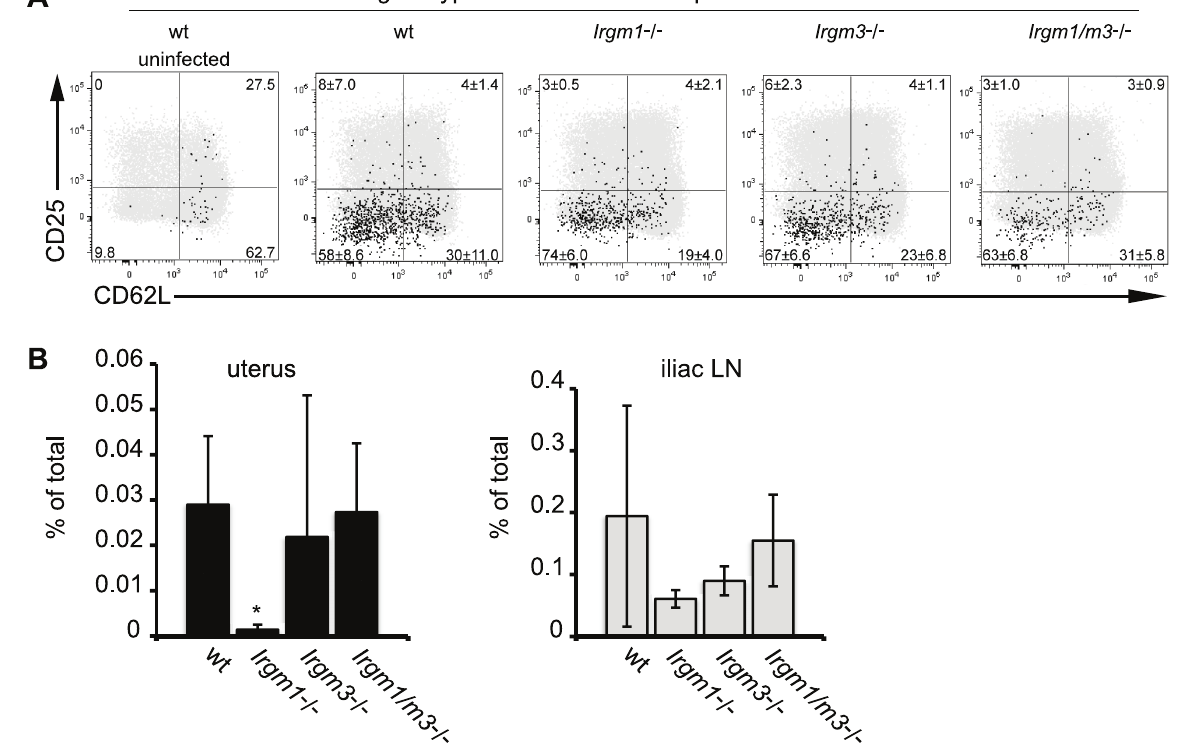
Figure 1. Concomitant deletion of Irgm3 rescues the expansion defect of Irgm1 -/- CD4 + T cells. Wildtype B6 mice were injected with naı¨ve, NR1-transgene expressing T cells derived from mice with the indicated genotypes. The next day mice were challenged with 2 * 10 6 IFUs of C. trachomatis directly instilled into the uterus. On day 6 post-infection, flow cytometry was used to analyze cells from the uterus and draining lymph node (A). C. trachomatis -specific NR1 cells resident in the iliac lymph nodes were assessed for the expression of activation markers CD25 and CD62L. Total CD4 + cells are shown as gray dots, NR1 cells are shown as black dots. (B) The percentage of total live NR1 cells was calculated for uterus (left panel) and draining lymph node (right panel). Flow cytometry data are representative of three independent experiments. Statistical analysis was performed via Student’s t test. *, p , 0.05.